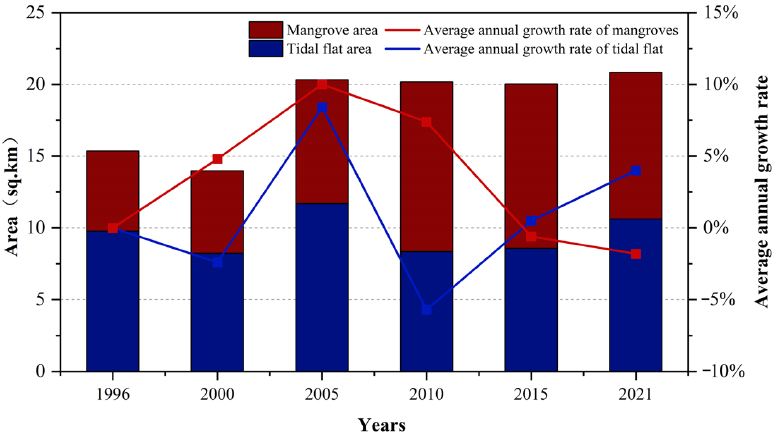
Figure 17. Map of land stock and annual growth rate in Shankou region from 1996 to 2021.